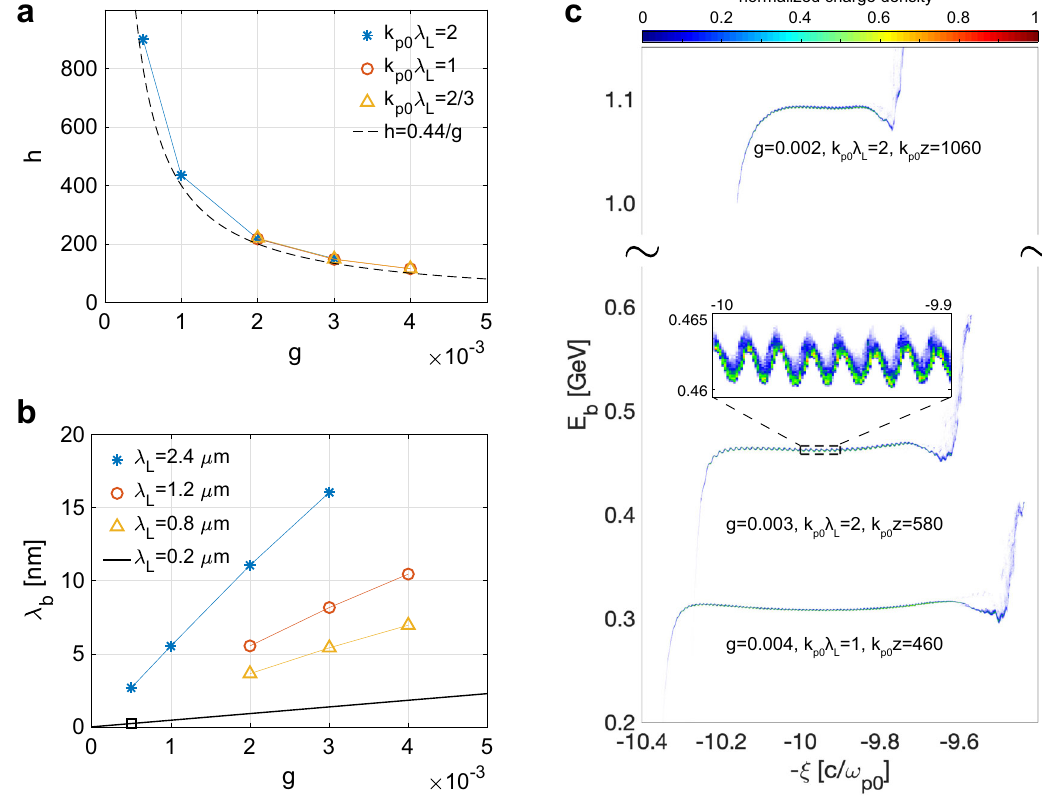
Fig. 3 Tunability of the bunching wavelength and fl at longitudinal phase space of the injected beams. a The dependence of harmonic number h on the normalized density gradient g under different colliding lasers. b The modulation wavelength when different ramps and lasers are used where n p0 = 1.97 × 10 19 cm − 3 . c The longitudinal phase space of the injected electrons at their optimized acceleration distance. The inset shows the sinusoidal energy